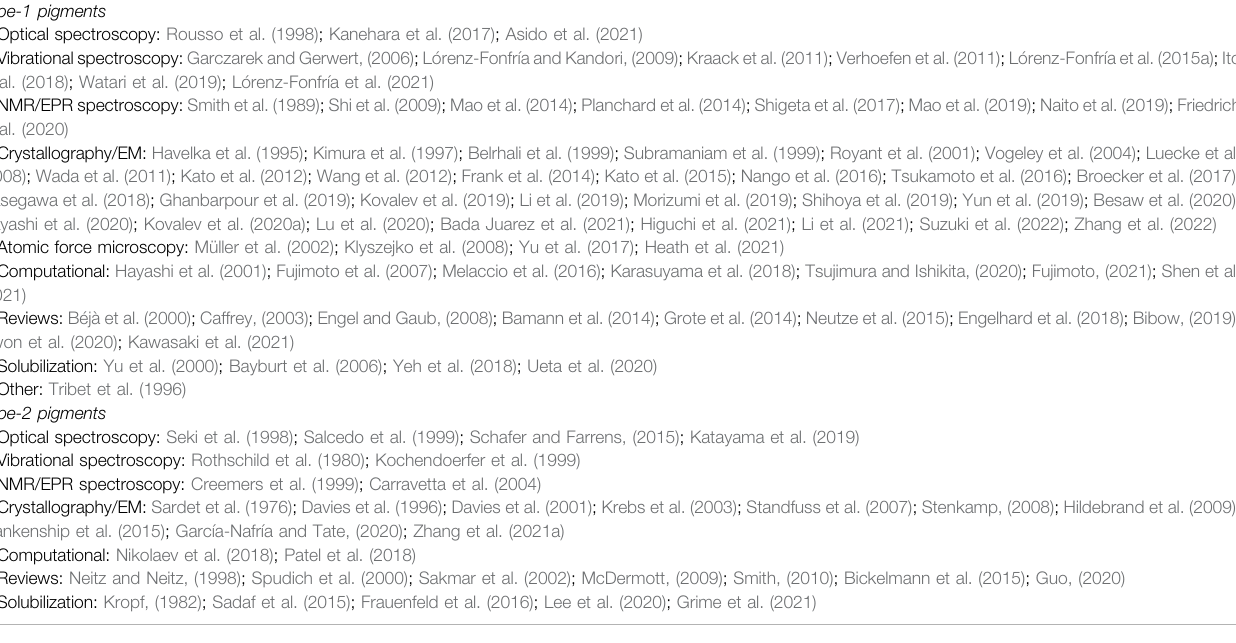
TABLE 1 | Selected additional citations for the section “ Spectral and structural properties and solubilization ” . Type-1 pigments Optical spectroscopy: Rousso et al. (1998); Kanehara et al. (2017); Asido et al. (2021) Vibrationalspectroscopy: Garczarek and Gerwert, (2006); Lórenz-Fonfría and Kandori, (2009); Kraack et al. (2011); Verhoefen et al.(2011); Lórenz-Fonfríaet al.(2015a); Ito et al. (2018); Watari et al. (2019); Lórenz-Fonfría et al. (2021) NMR/EPR spectroscopy: Smith et al. (1989); Shi et al. (2009); Mao et al. (2014); Planchard et al. (2014); Shigeta et al. (2017); Mao et al. (2019); Naito et al. (2019); Friedrich et al. (2020) Crystallography/EM: Havelka et al. (1995); Kimura et al. (1997); Belrhali et al. (1999); Subramaniam et al. (1999); Royant et al. (2001); Vogeley et al. (2004); Luecke et al. (2008); Wada et al. (2011); Kato et al. (2012); Wang et al. (2012); Frank et al. (2014); Kato et al. (2015); Nango et al. (2016); Tsukamoto et al. (2016); Broecker et al. (2017); Hasegawa et al. (2018); Ghanbarpour et al. (2019); Kovalev et al. (2019); Li et al. (2019); Morizumi et al. (2019); Shihoya et al. (2019); Yun et al. (2019); Besaw et al. (2020); Hayashi et al. (2020); Kovalev et al. (2020a); Lu et al. (2020); Bada Juarez et al. (2021); Higuchi et al. (2021); Li et al. (2021); Suzuki et al. (2022); Zhang et al. (2022) Atomic force microscopy: Müller et al. (2002); Klyszejko et al. (2008); Yu et al. (2017); Heath et al. (2021) Computational: Hayashi et al. (2001); Fujimoto et al. (2007); Melaccio et al. (2016); Karasuyama et al. (2018); Tsujimura and Ishikita, (2020); Fujimoto, (2021); Shen et al. (2021) Reviews: Béjà et al. (2000); Caffrey, (2003); Engel and Gaub, (2008); Bamann et al. (2014); Grote et al. (2014); Neutze et al. (2015); Engelhard et al. (2018); Bibow, (2019); Kwon et al. (2020); Kawasaki et al. (2021) Solubilization: Yu et al. (2000); Bayburt et al. (2006); Yeh et al. (2018); Ueta et al. (2020) Other: Tribet et al. (1996) Type-2 pigments Optical spectroscopy: Seki et al. (1998); Salcedo et al. (1999); Schafer and Farrens, (2015); Katayama et al. (2019) Vibrational spectroscopy: Rothschild et al. (1980); Kochendoerfer et al. (1999) NMR/EPR spectroscopy: Creemers et al. (1999); Carravetta et al. (2004) Crystallography/EM: Sardet et al. (1976); Davies et al. (1996); Davies et al. (2001); Krebs et al. (2003); Standfuss et al. (2007); Stenkamp, (2008); Hildebrand et al. (2009); Blankenship et al. (2015); García-Nafría and Tate, (2020); Zhang et al.